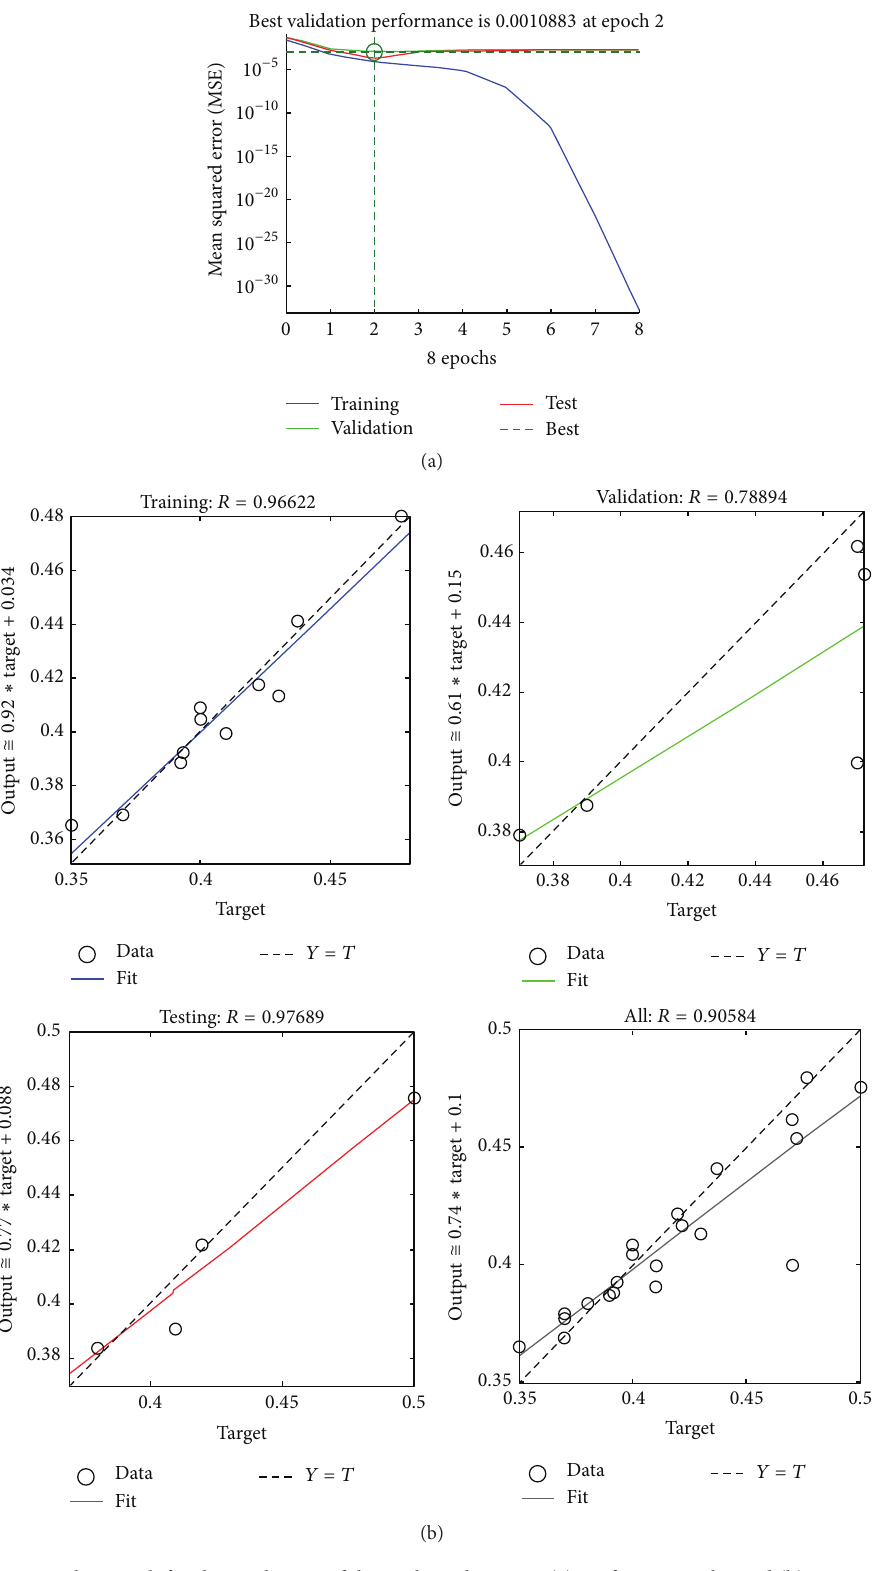
Figure 4: Neural network for the prediction of thermal conductivity: (a) performance plot and (b) regression